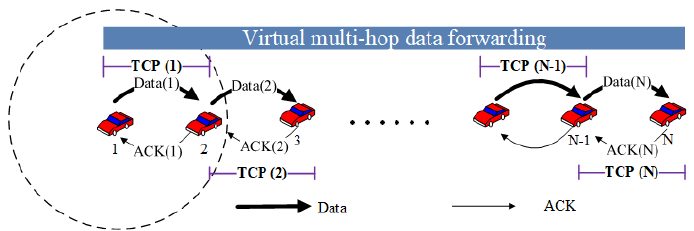
Figure 8. Virtual multi-hop data forwarding (dashed circle shows the transmission range).